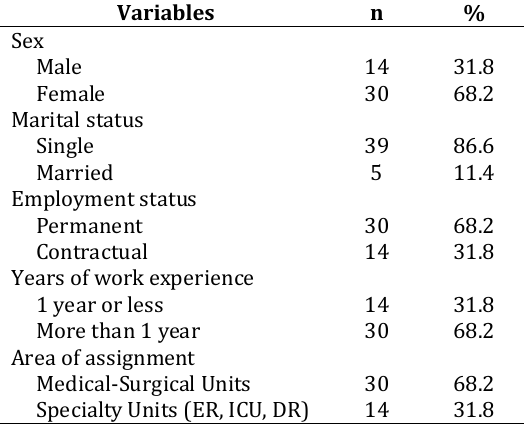
Table 1. Demographic and work-related profile